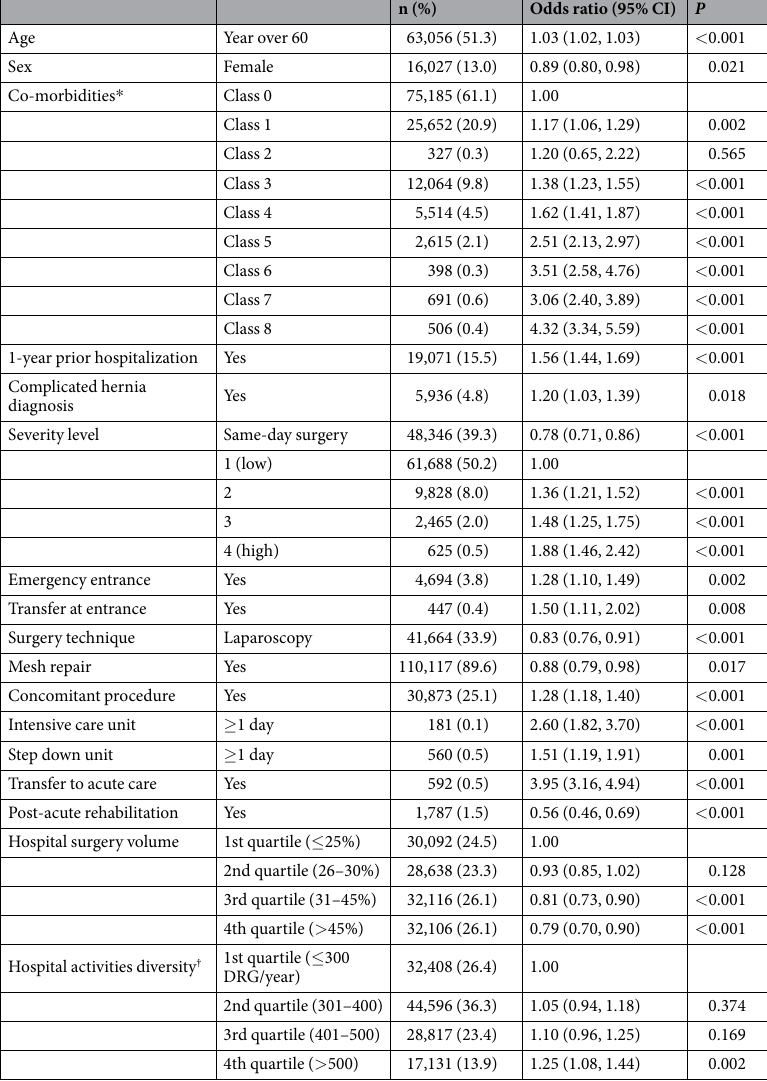
Table 2. Adjusted effects on readmission risk. † DRG, diagnosis-related groups. * Co-morbidity classes: ( 0 ) no condition; ( 1 ) other conditions; ( 2 ) infectious and parasitic diseases; ( 3 ) diseases of the digestive, respiratory, genitourinary, or nervous system, or injury, poisoning or certain other consequences of external causes; ( 4 ) any combinations between diseases of the digestive, respiratory, genitourinary, or circulatory system, or endocrine, nutritional or metabolic diseases, or congenital malformations, deformations or chromosomal abnormalities, or injury, poisoning or certain other consequences of external causes; ( 5 ) any combinations of symptoms, signs and abnormal clinical and laboratory findings, not elsewhere classified with any other diseases; ( 6 ) any combinations of symptoms, signs and abnormal clinical and laboratory findings not elsewhere classified with diseases of the genitourinary system; ( 7 ) any combinations of symptoms, signs and abnormal clinical and laboratory findings not elsewhere classified with diseases of the digestive system; ( 8 ) any combinations of symptoms, signs and abnormal clinical and laboratory findings not elsewhere classified with diseases of the respiratory